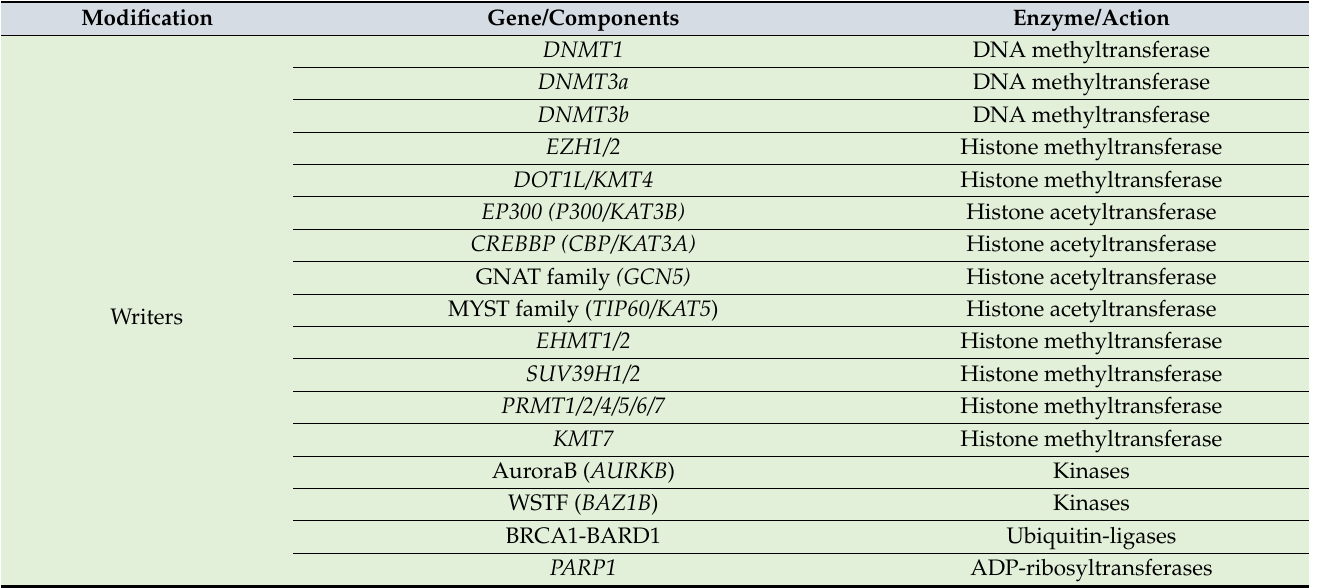
Figure 2. Factors involved in regulating epigenetic code. Histones undergoes different PTMs such as methylation, acetylation, phosphorylation, ubiquitination and ADP-ribosylation. Writers and erasers are involved in adding and removing PTM, respectively. Readers with specific domains recognizes the PTMs. This figure was created using BioRender.com (accessed on 14 December 2022). Table 1. Proteins involved in chromatin organization, adapted from